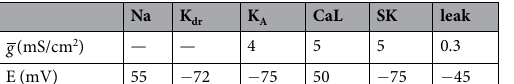
Table 1. The fast sodium current plays a major role in action potential initiation and propagation 106 and the delayed